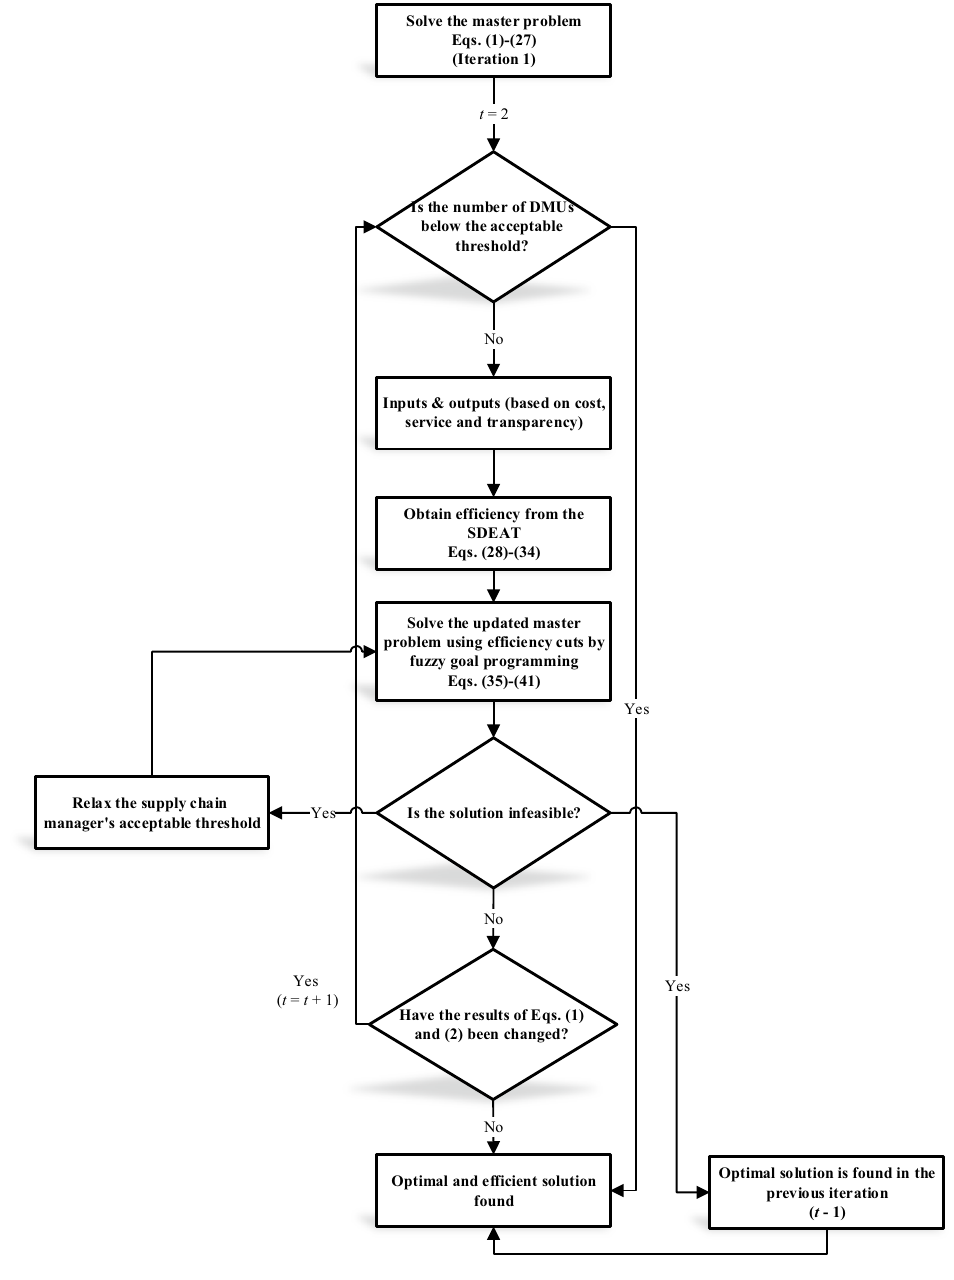
Figure 2. Flowchart of the proposed B&E